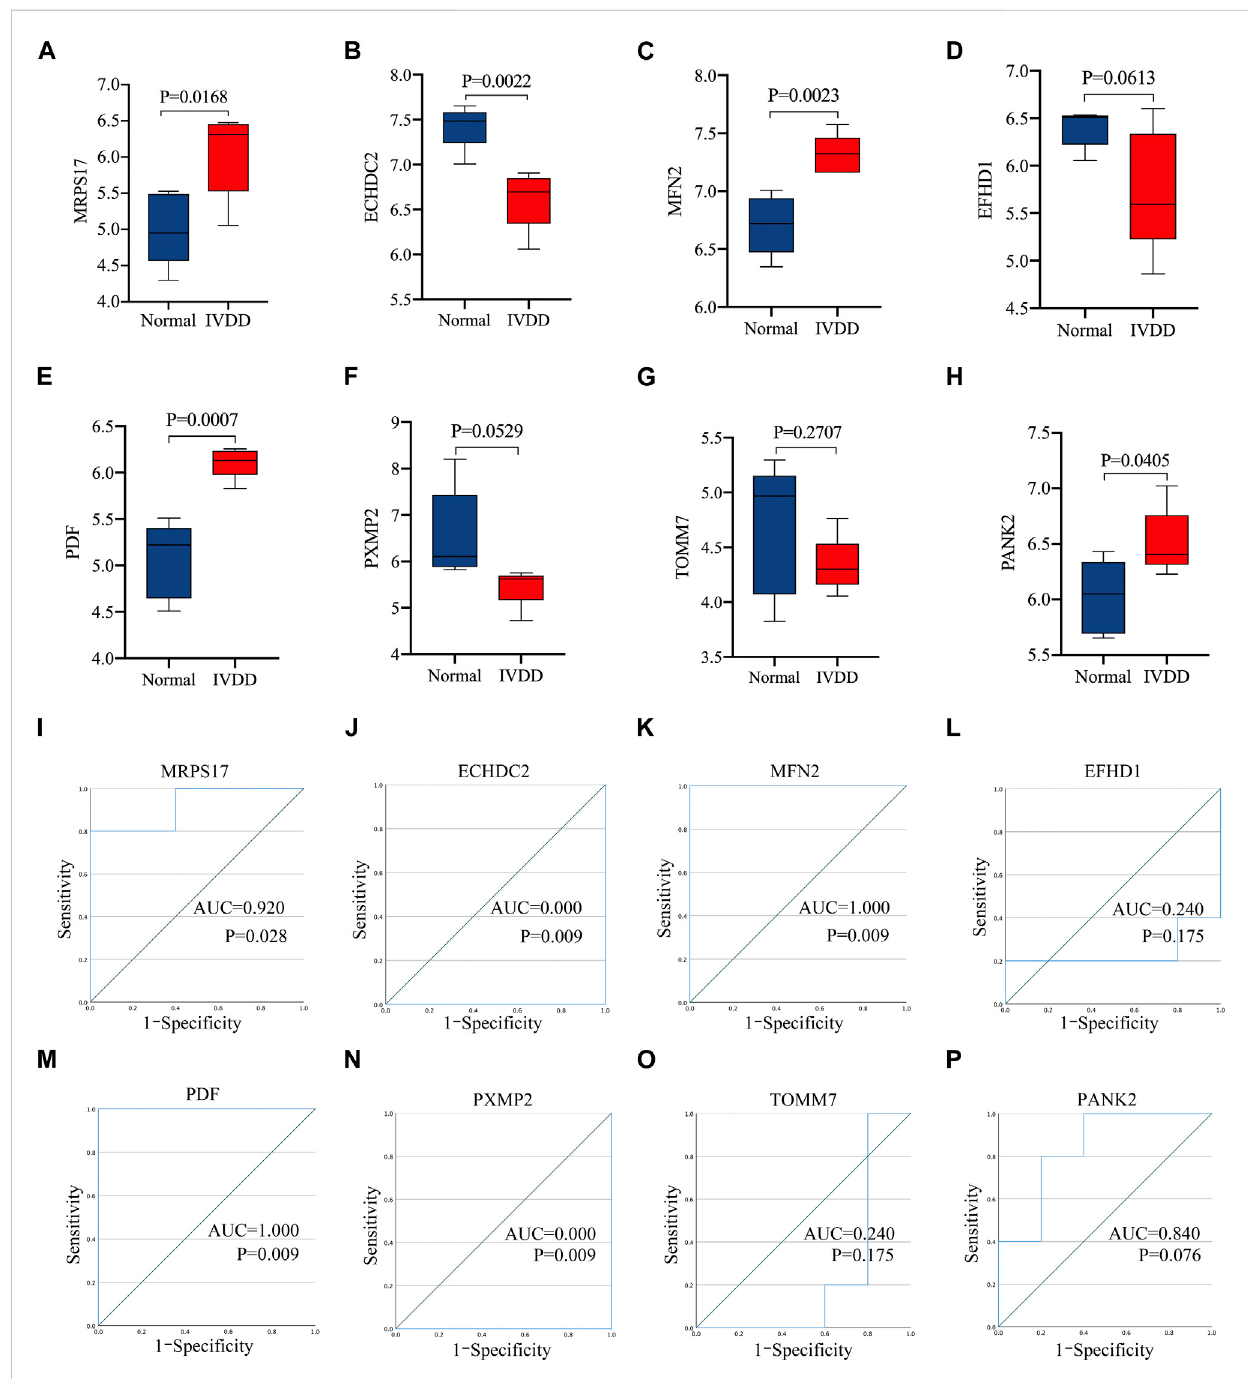
FIGURE 4 The performance of the signature genes. (A – H) Signature gene expression levels in the nucleus pulposus tissue of IVD degeneration patient and healthy subjects. (I – P) The diagnostic performance of signature genes was evaluated by